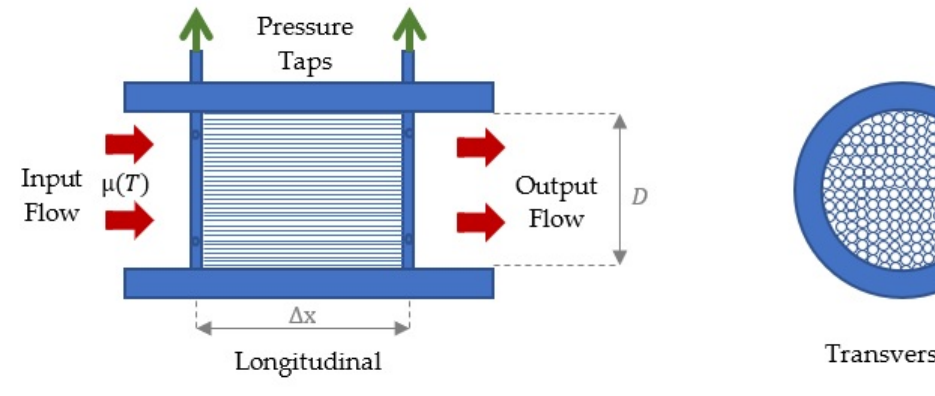
Figure 1. Laminar flowmeter.